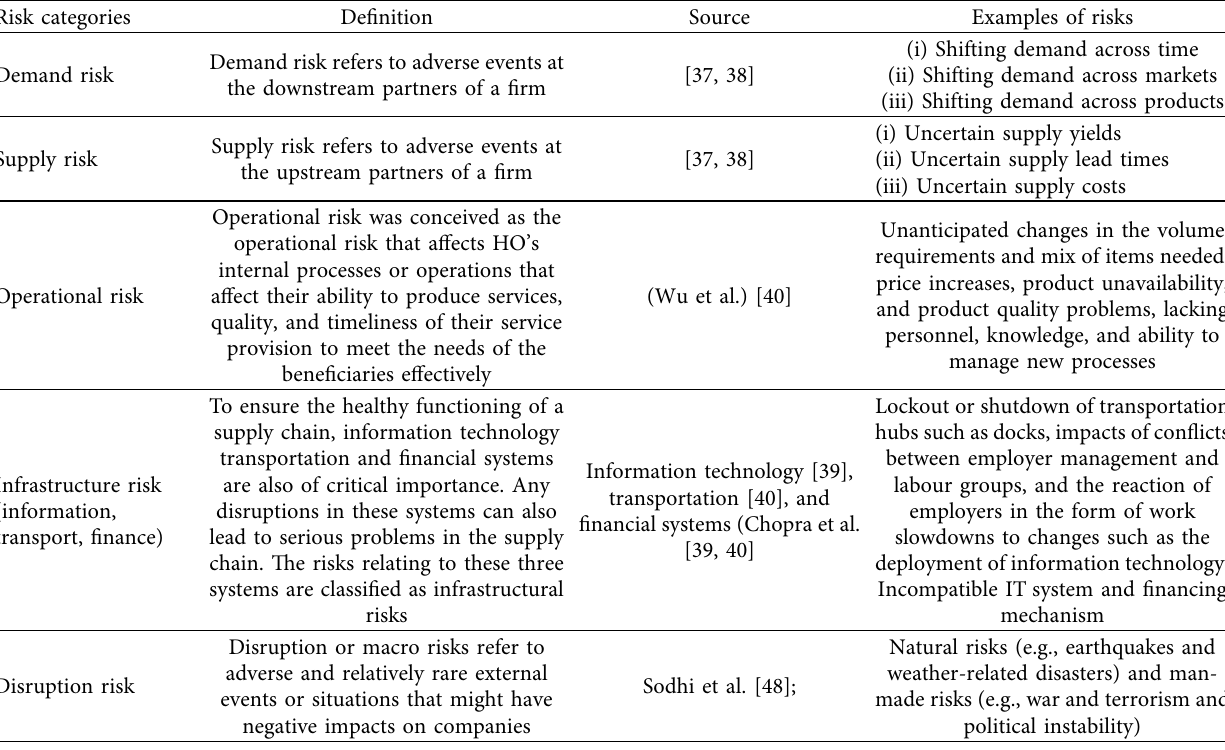
Table 1: Definitions and examples of the risk categories.